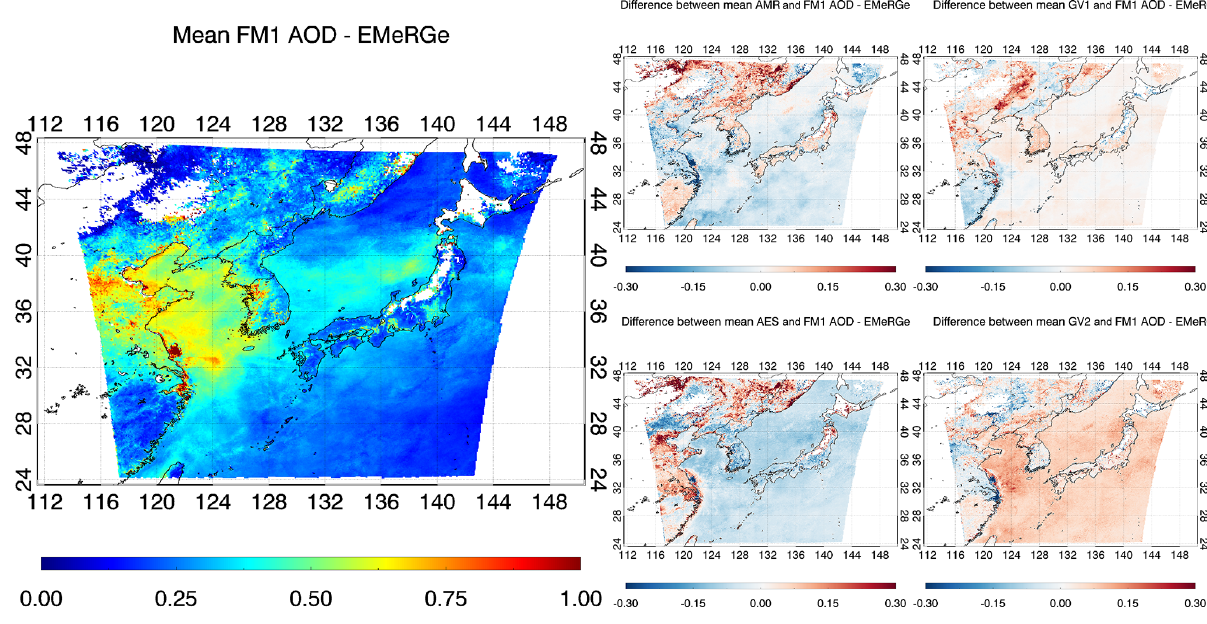
Figure 5. Same as Fig. 4 but for the EMeRGe campaign.